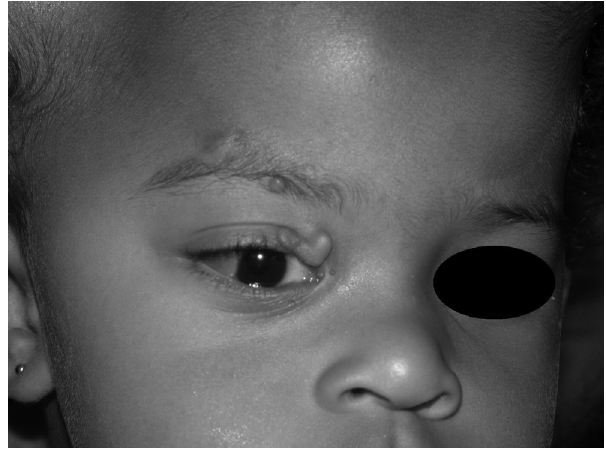
Figure 2 - The choriocystoma and the lipomas of the